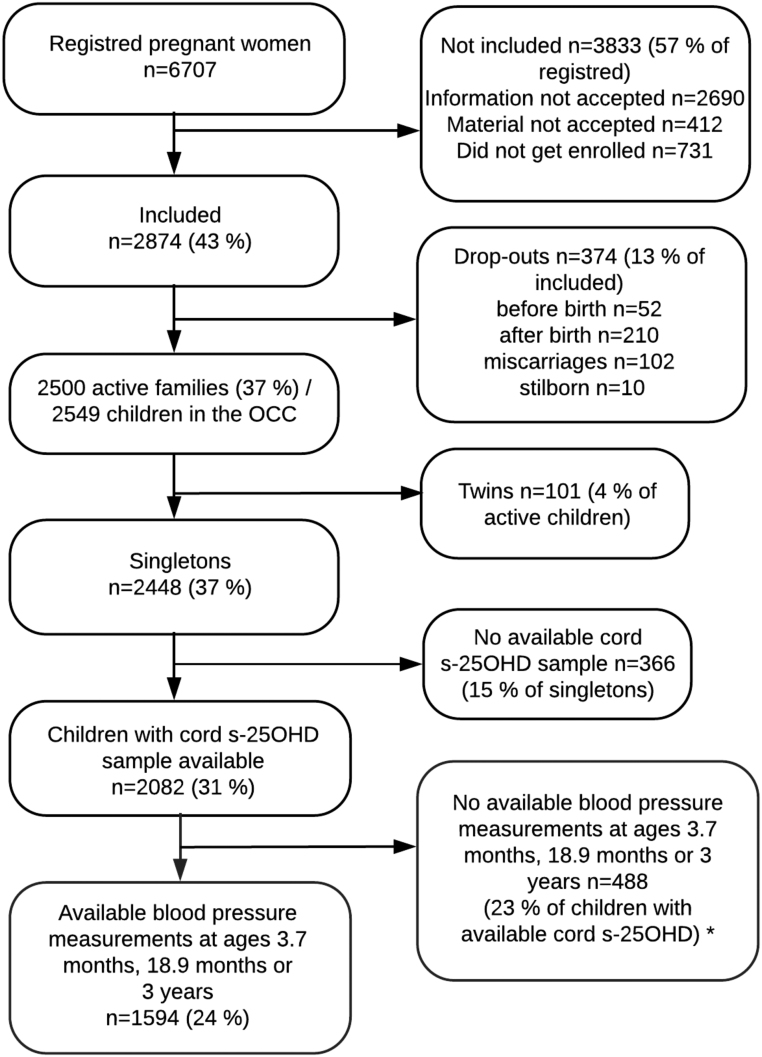
Flowchart of the study population. OCC, Odense Child Cohort; s-25OHD, serum 25-hydroxyvitamin D2+3. *Five measurements of systolic blood pressure and four of diastolic blood pressure were regarded an error of data entry and therefore coded as missing.